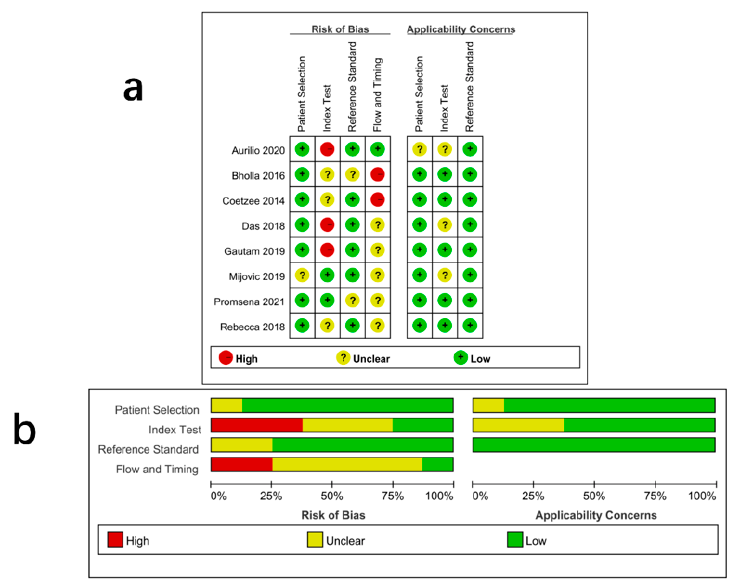
Figure 2. Quality evaluation of the included studies: ( a ) risk of bias and applicability concerns summary, ( b ) risk of bias and applicability concerns graph.